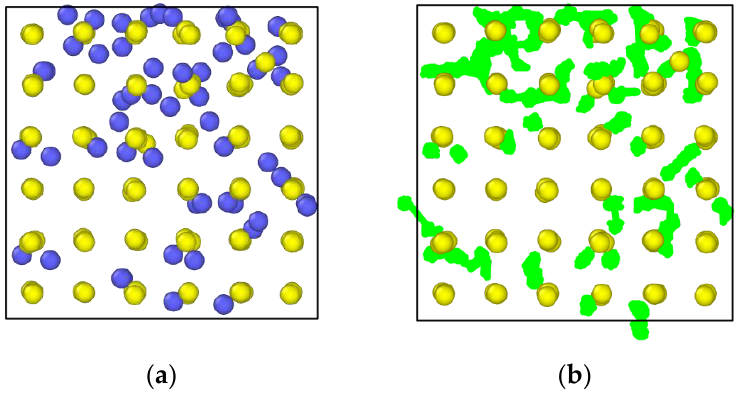
Figure 6. In 2 O 3 doped with 22% percent zirconium. ( a ) Substitutional zirconium atoms in yellow, interstitial oxygen atoms in the last data dump of the simulation in blue, ( b ) the diffusion paths of those oxygen atoms in green.